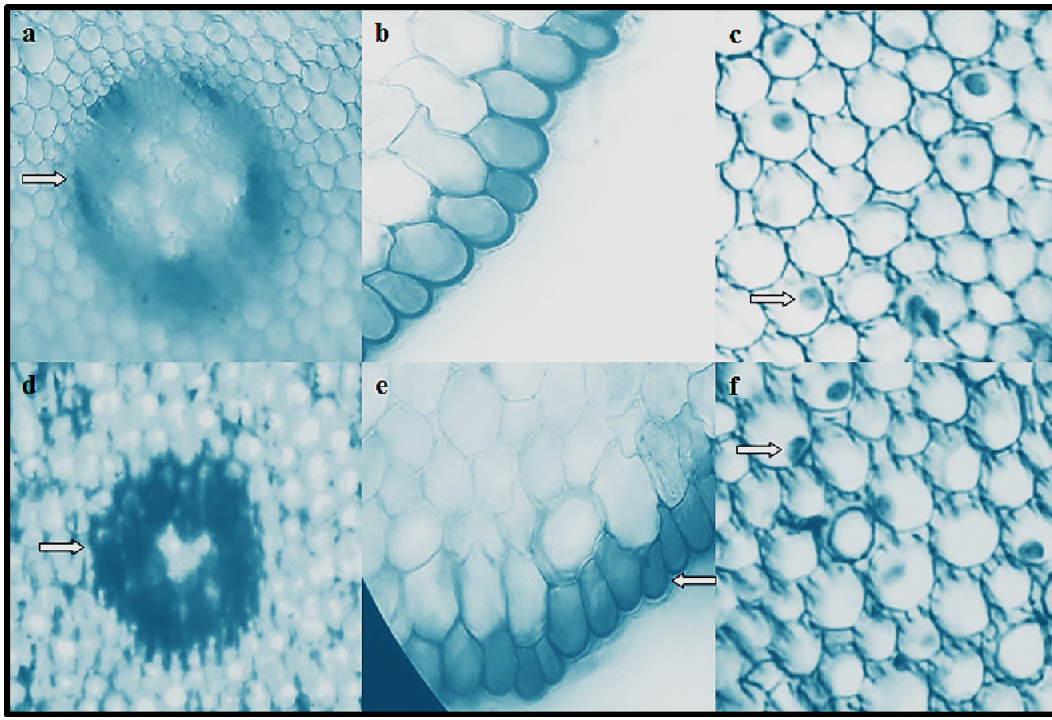
Figure 5. Meristematic cell injuries provoked by dithane exposure. Normal appearance of vascular tissue ( a ), normal appearance of epidermis cells ( b ), normal appearance of cell nucleus-oval ( c ), indistinct appearance of vascular tissue ( d ), epidermis cell damage ( e ), flattened cell nucleus ( f